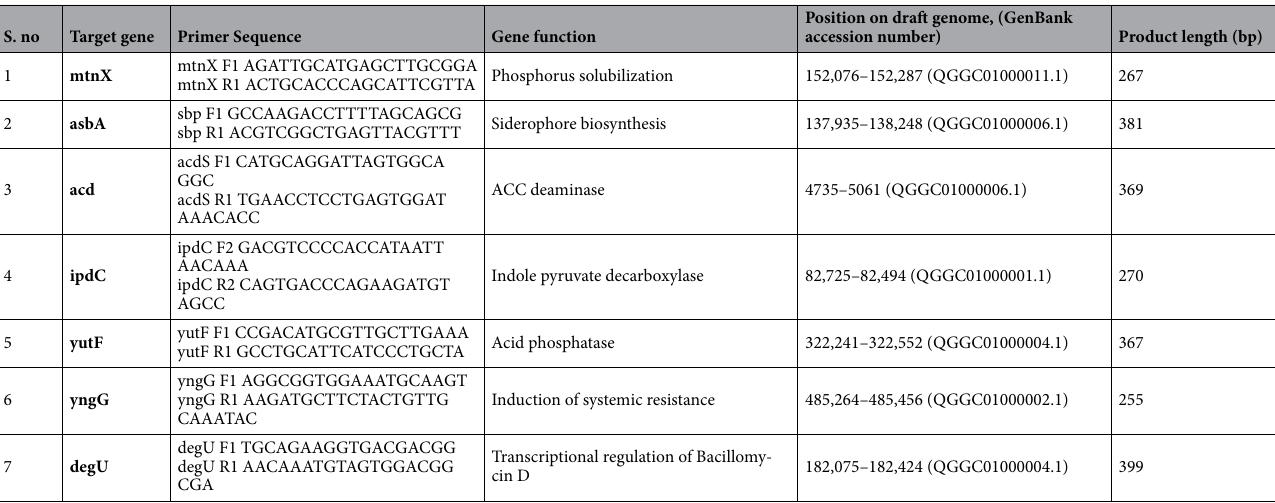
Table 4. Bar D5 genes for plant growth promotion and secondary metabolism amplified and mapped on draft